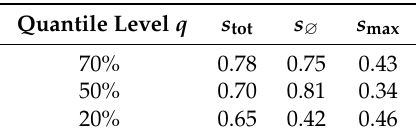
Table 6. Correlation coefficients (Kendall’s method) between the surface characteristics of compressed (30%) and uncompressed